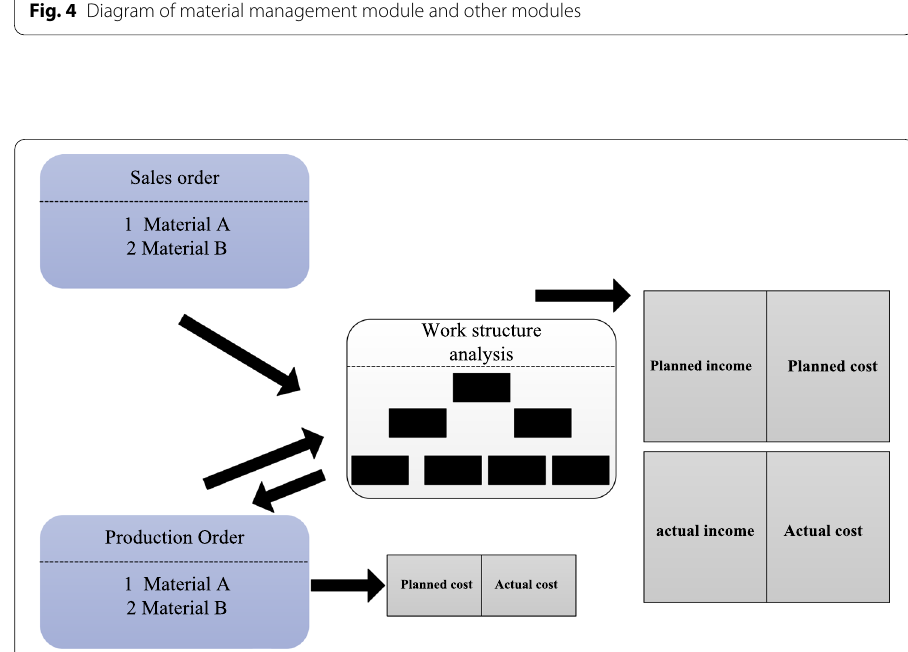
Fig. 5 Order and project